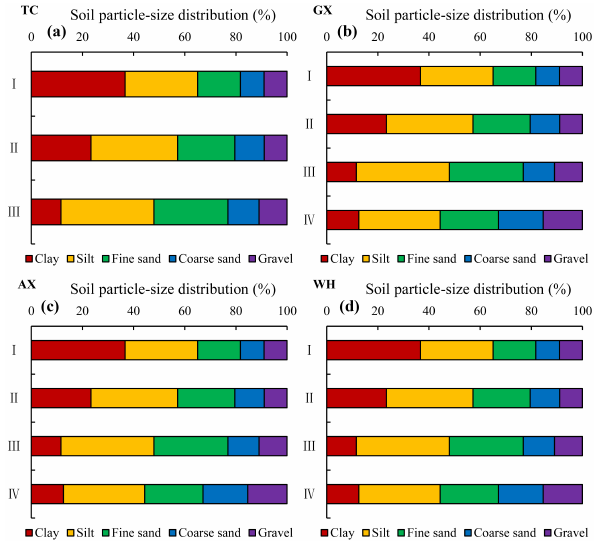
Figure 4. Averages of soil Atterberg limits for different weathering profiles of the four collapsing gullies. (a) Plastic limit, (b) liquid limit, (c) plasticity index and (d) liquidity